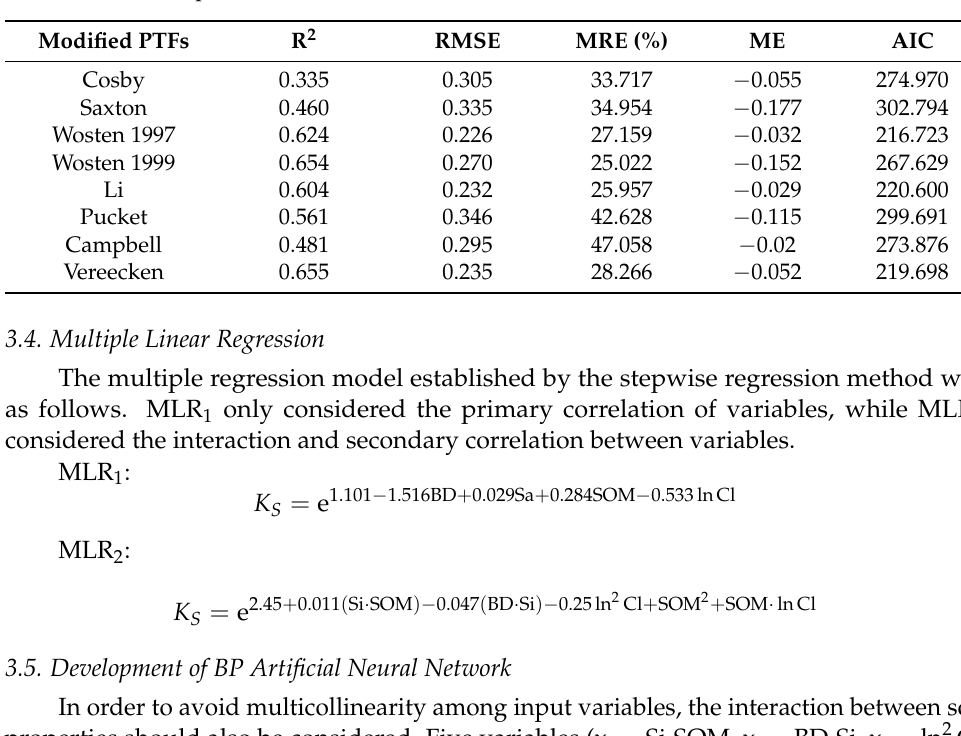
Table 5. Predictive performance of the modified PTFs.